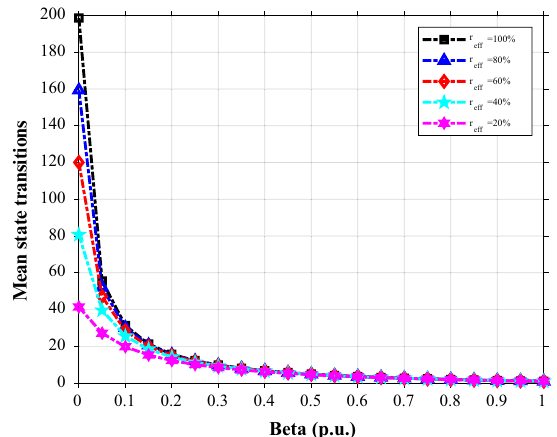
Fig. 10 Mean system state transitions with imperfect repairs—99% diagnostic coverage